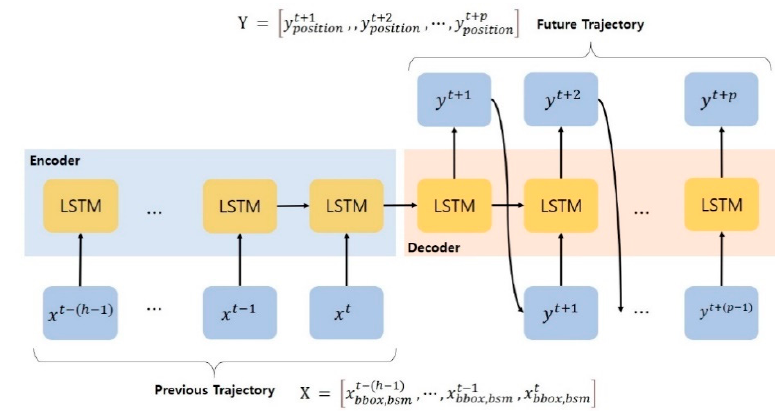
Figure 10. LSTM encoder-decoder architecture for trajectory prediction model.